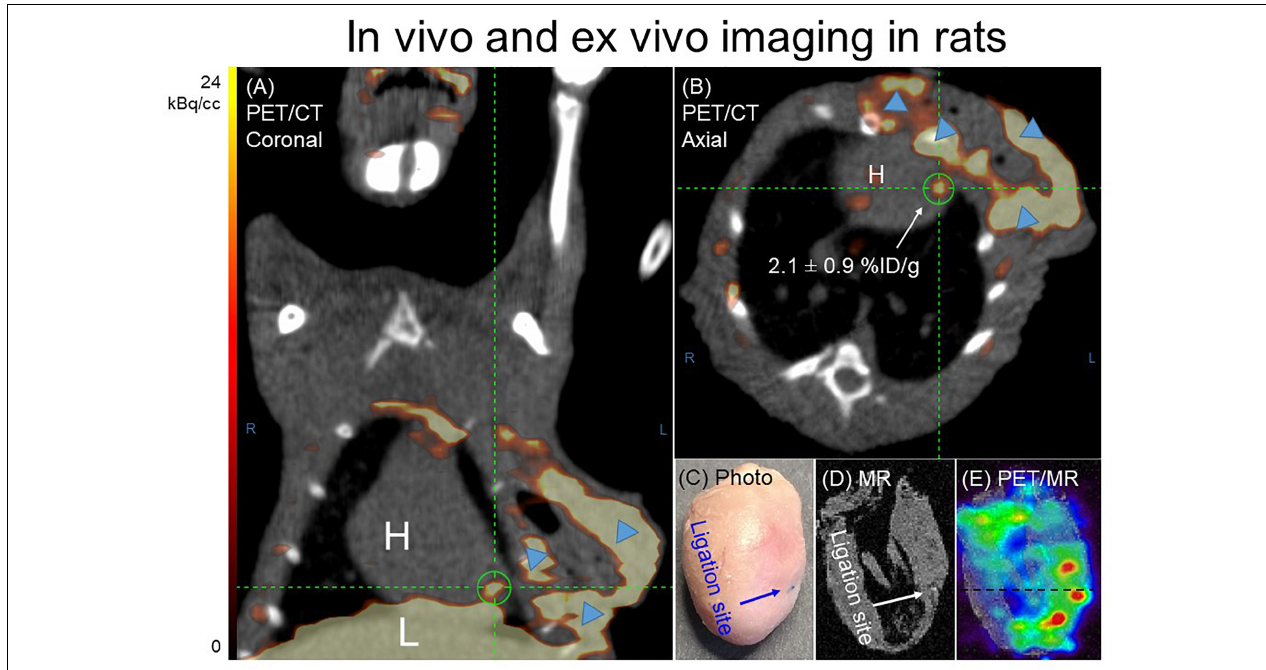
FIGURE 4 | Representative 68 Ga-NOTA-anti-MMR Nb PET/CT (A) coronal and (B) axial images. In order to validate the results obtained by in vivo PET/CT imaging and to confirm the cardiac origin of the in vivo signal ( n = 7), hearts from two MI-induced rats were also scanned ex vivo . (C) Photograph, (D) MRI only and (E) PET/MRI of the representative heart excised from rat, 7 days after coronary ligation, confirmed an augmented 68 Ga-NOTA-anti-MMR Nb uptake in the area close to the ligation site. 68 Ga-NOTA-anti-MMR Nb exhibited elevated uptake in scars from operation (blue